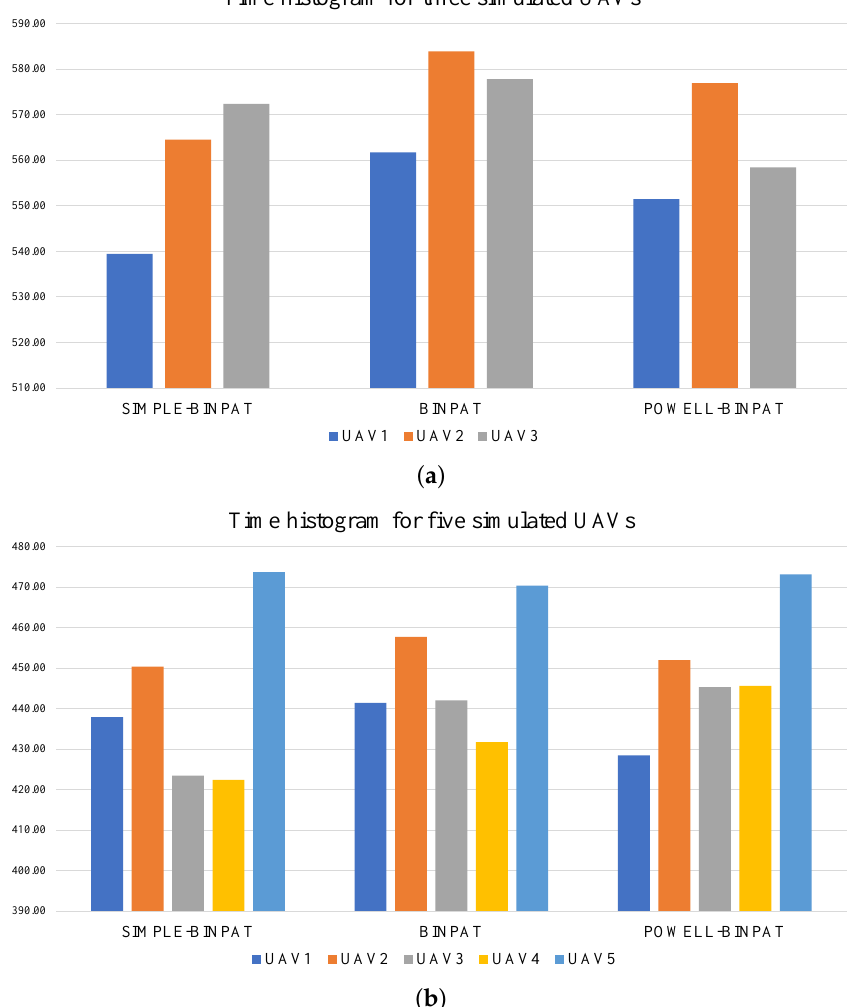
Figure 12. Time histograms for average results in simulation tests: ( a ) three UAVs’ time histogram; and ( b ) five UAVs’ time